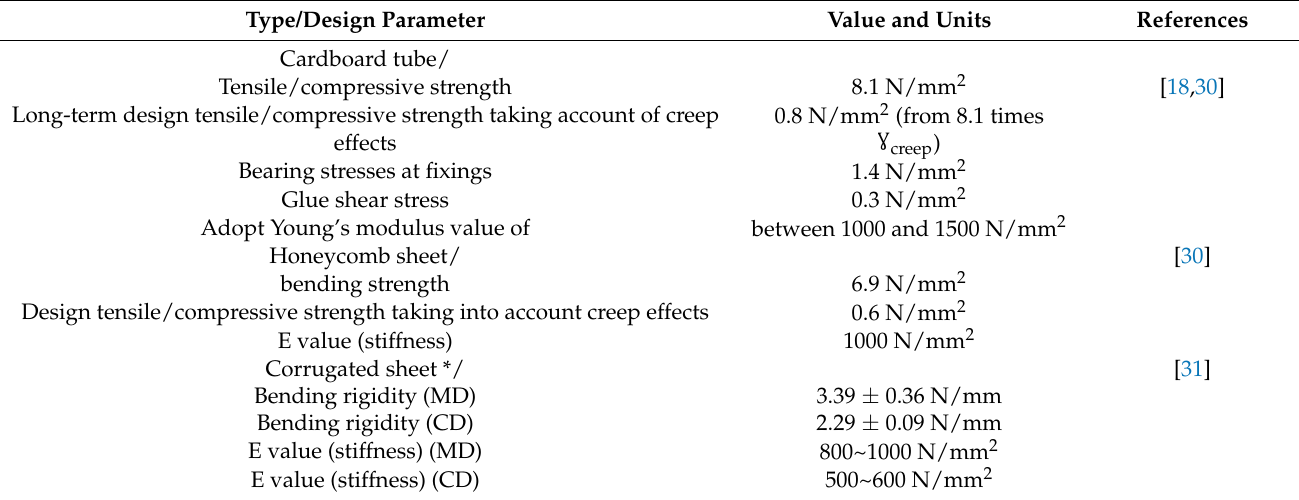
Table 2. Design parameters of cardboard.